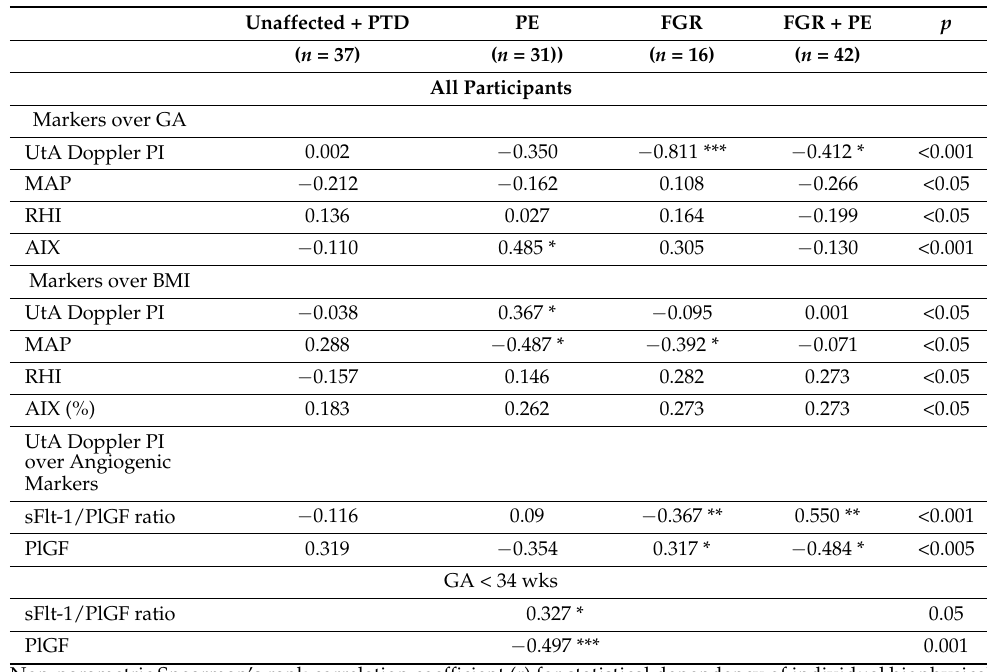
Table 2. Spearman’s correlation coefficient (r) between biophysical markers and patients .